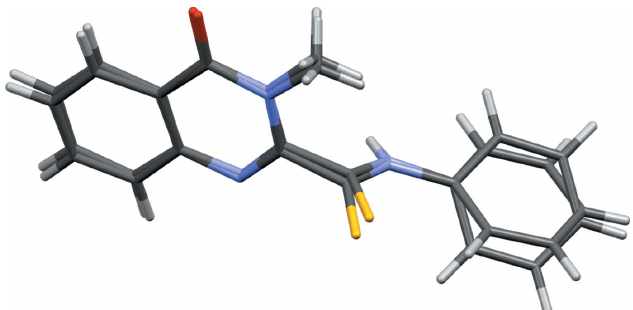
Figure 2 Overlay plot of the two independent molecules in the title compound.